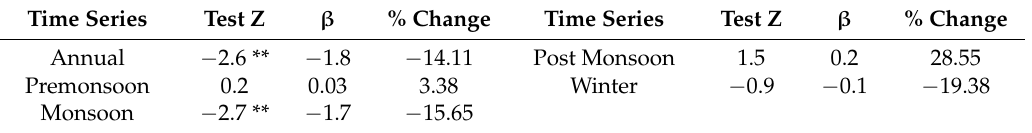
Table 7. Mann Kendall and Percent change analysis over entire Jharkhand.